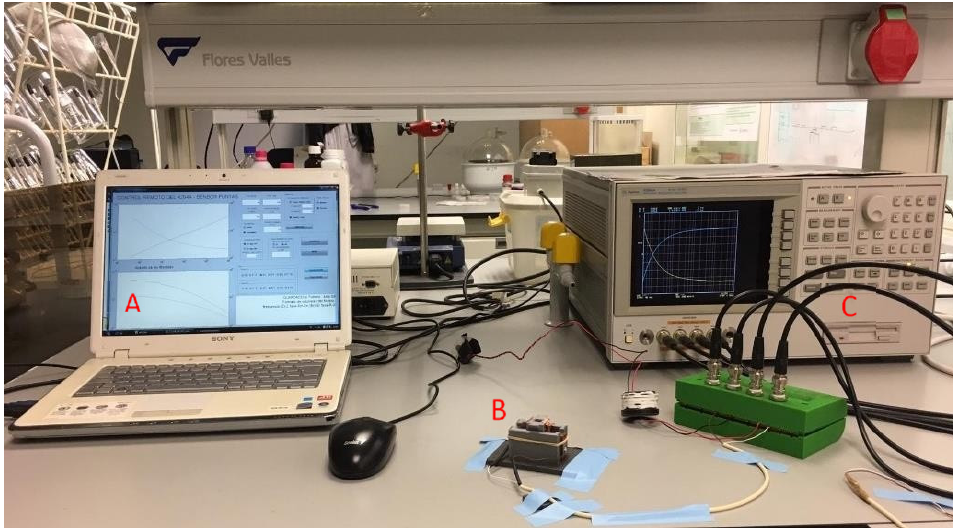
Figure 3. Set-up used to determine release kinetics. ( A ) Computer that collects the data from the impedance analyzer; ( B ) measuring tank and outer shell; ( C ) Impedance analyzer.